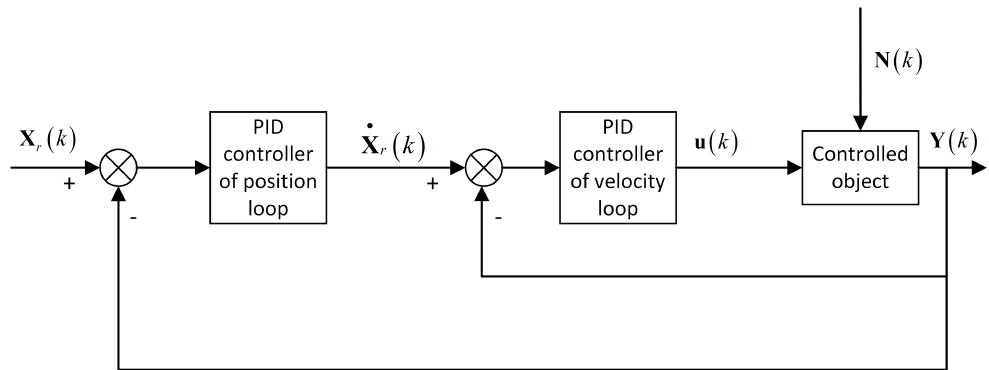
Figure 11. Schematic diagram of the PID controller’s